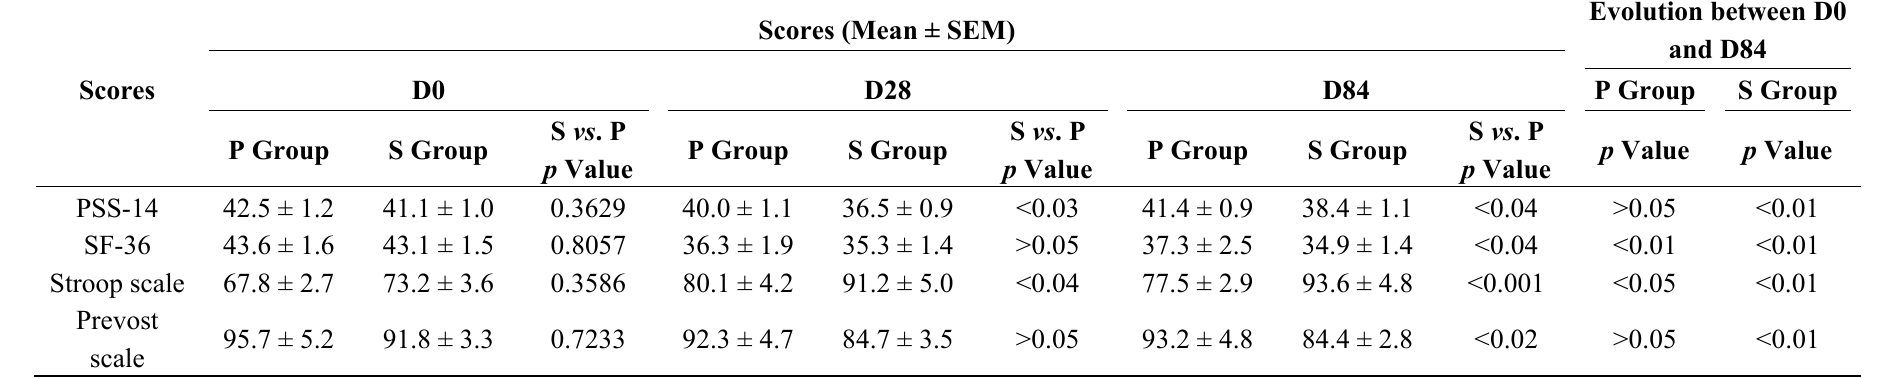
Table 2. Scores at D0, D28, and D84, transverse comparison between supplement group (S) and placebo group (P) and evolution between D0 and D84 for P and S groups.